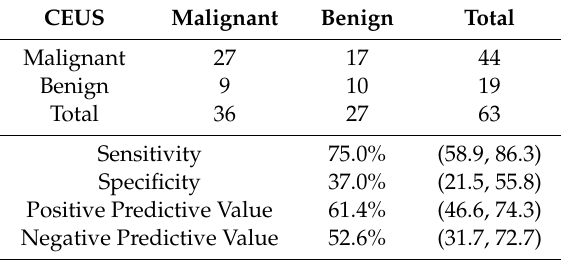
Table 5. Accuracy of CEUS in comparison to histology, taken as gold standard (CI 95%).